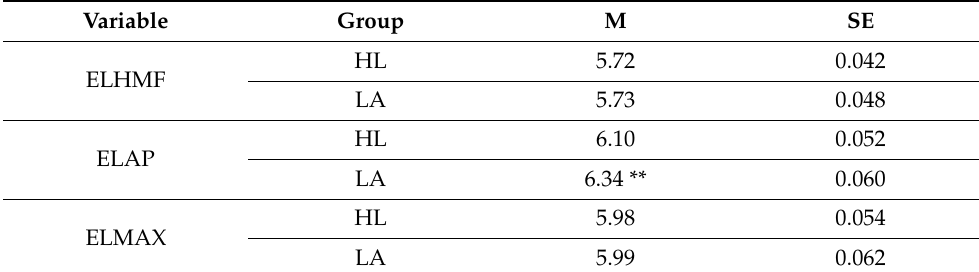
Table 3. Electrical conductivity traits (mS/cm) in milk of cows, ( n =